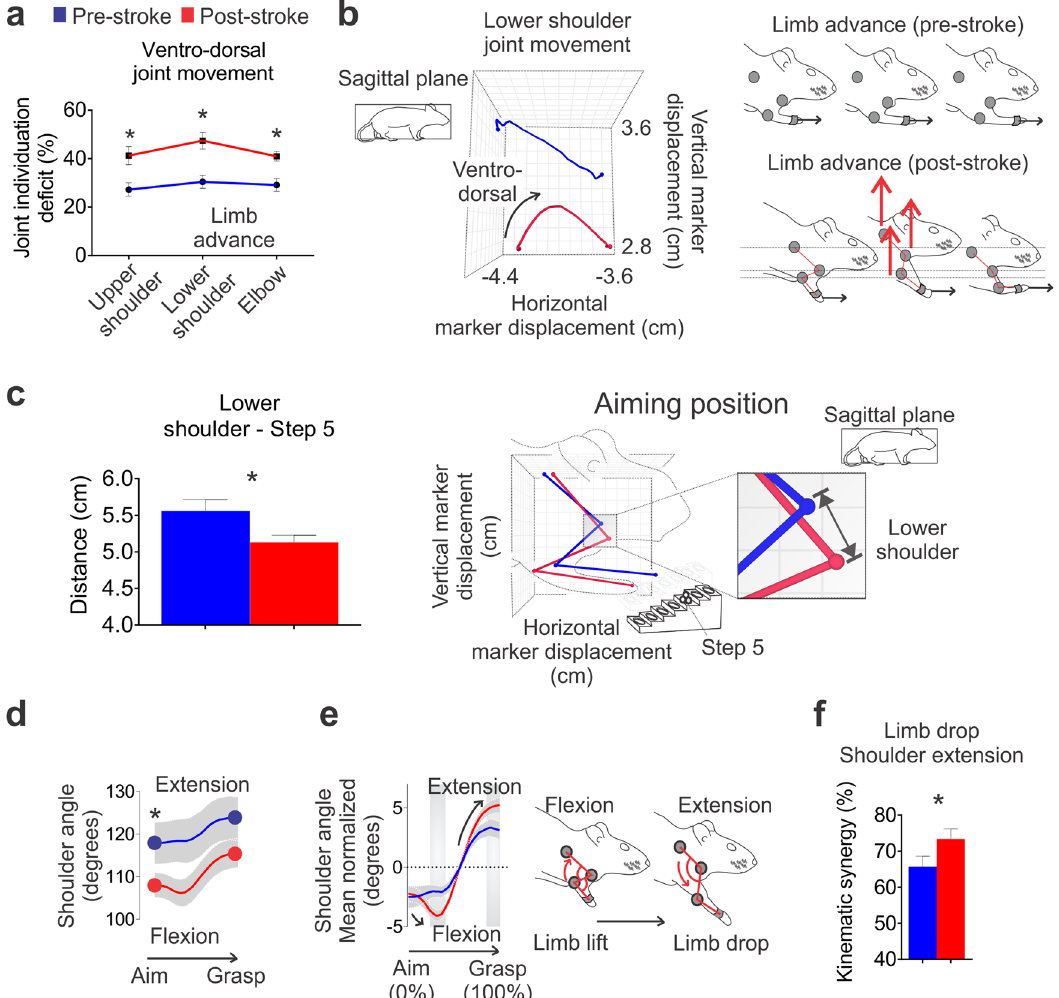
Figure 5. Post-stroke reaching displays less individuated movements and more shoulder extension. ( a ) Excessive elbow and shoulder ventro-dorsal movements were evident during limb advance following stroke. ( b ) An example of increased lower shoulder ventro-dorsal movements observed following stroke (black arrow in the left panel). A schematic illustration of these movement abnormalities (red arrows in the right panel). ( c ) Following stroke, the lower shoulder was postitioned closer to the target (step 5) during the initial aiming position. ( d ) Post-stroke, the shoulder was more flexed while at the aiming position. ( e ) Increased shoulder flexion and extension was evident following stroke during the initial and final stages of reaching, respectively (black arrows in the left panel); visual representation of the increased shoulder flexion during limb lift and shoulder extension during limb drop (right panel). ( f ) During limb drop, there was increased shoulder extension synergy post-stroke. Mean traces and stick figures (n = 13). Paired t-test, * p < 0.05. Linear mixed effects modeling and Bonferroni-corrected post-hoc tests, shaded areas p < 0.05, mean, or mean ±